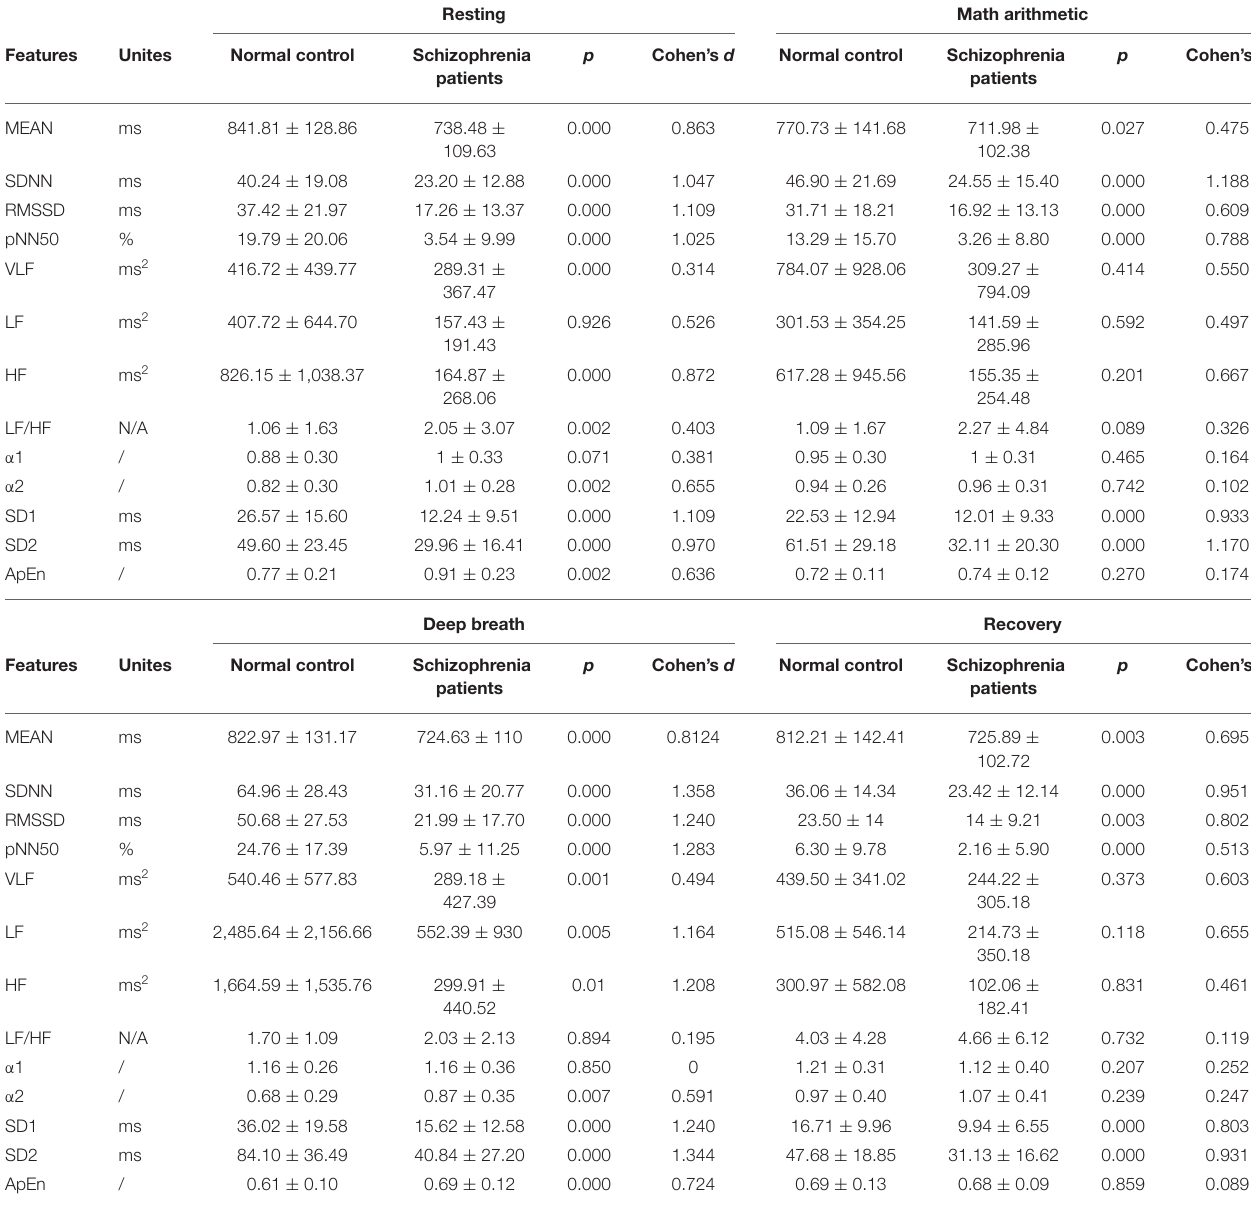
TABLE 2 | Sample characteristics and analyses of between-group differences.